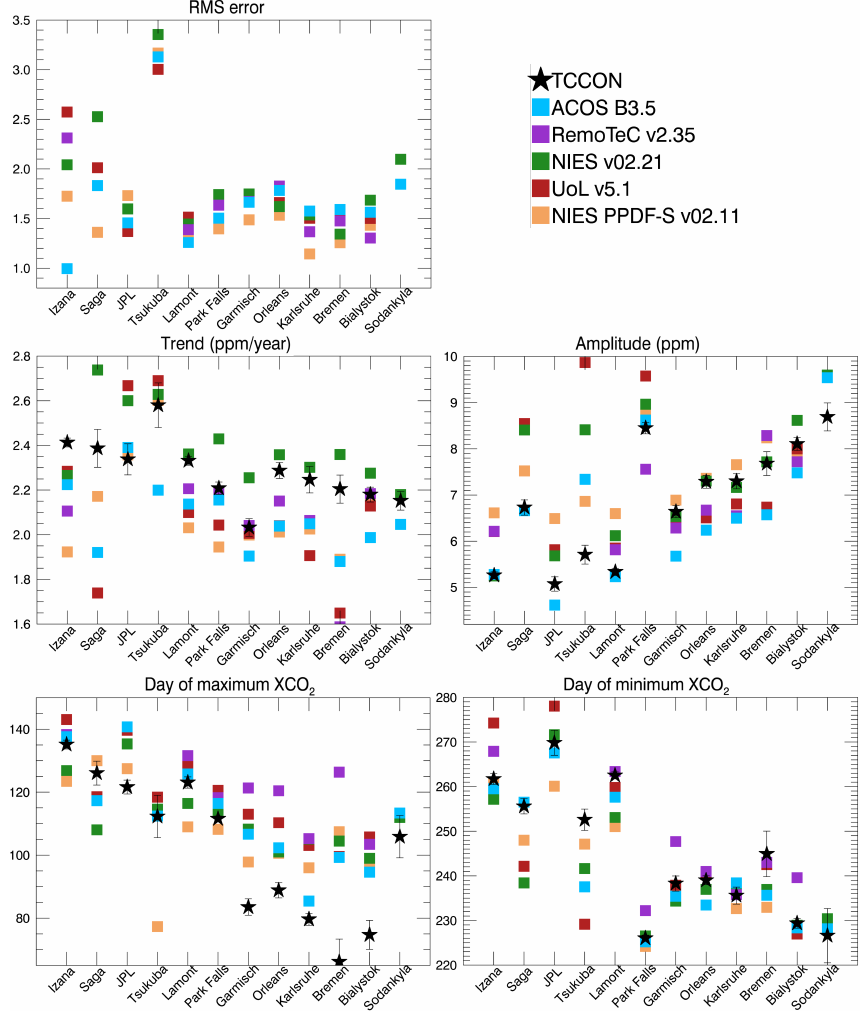
Figure 6. Comparison of the GOSAT and TCCON XCO 2 time series using the following parameters: root-mean-square (RMS) error (upper left panel), average trend (middle left panel), seasonal cycle amplitude (middle right panel), and the days of maximum and minimum XCO 2 (bottom row). Five retrieval algorithms were included to describe GOSAT observations. TCCON values were based on ACOS B3.5 co-located soundings. The 12 Northern Hemisphere validation sites are shown on the horizontal axis, their latitude increasing from left to